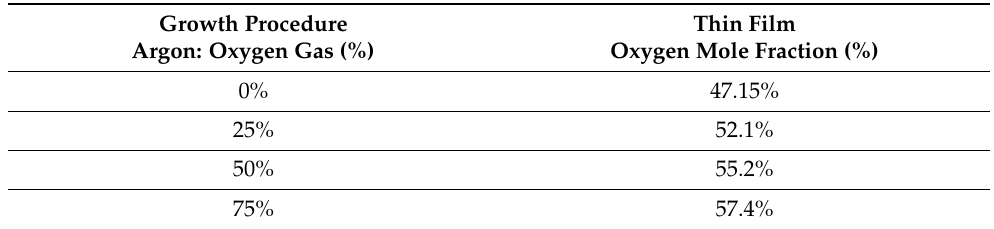
Table 2. The oxygen gas present of the growth procedure and oxygen fraction of as-deposited thin film from the XPS results.